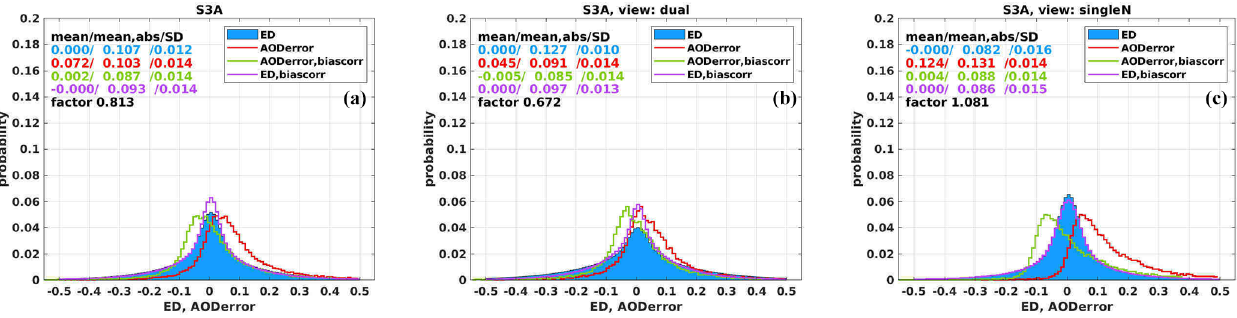
Figure 16. Histograms of the ED (blue filled bars), AOD errors (red; with bias correction: green), and ED calculated from uncertainties (purple; scaled to best fit the mean-bias-corrected error distribution) for all matchups (a) as well as dual (b) and singleN (c) groups of matchups. The statistics of mean, mean,abs, and SD are means over “real” values, means over “absolute” values, and standard deviation, respectively, for histograms of the corresponding